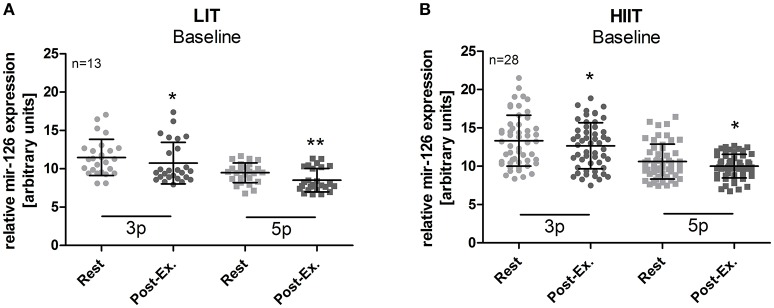
miR-126 levels were slightly reduced in response to exercise at baseline. The acute effect of a single exercise session on miR-126-3p and 5p levels before the intervention was determined in (A) the LIT group and (B) the HIIT groups. A significant decrease of miR-126-3p/-5p was detected post-exercise. LIT participants were tested before and after a 25 min low-intensity run, HIIT participants before and after 4 × 30 s (all-out) high-intensity runs with 30 s of active recovery periods at warm-up speed. Data are represented as mean ± SD. P-values are rest vs. post-exercise using ANOVA. *p < 0.05; **p < 0.01.